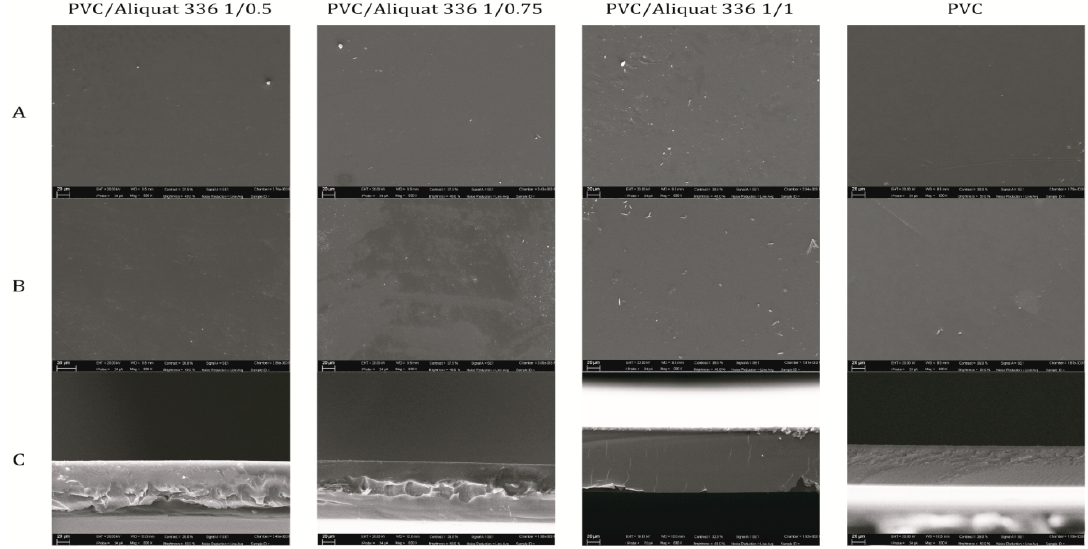
Figure 2. Scanning electron microscopy (SEM) images of the prepared membranes: ( A ) top surface, ( B ) bottom surface, and ( C ) cross-section.